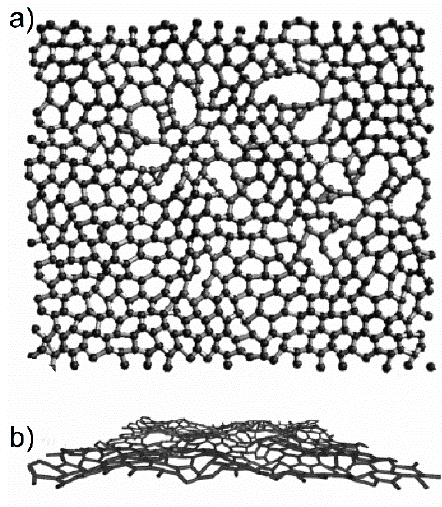
Figure 20. ( a ) Structure factor and ( b ) pair distribution function for glassy carbon heat-treated at 1000 °C, ED data—solid line, RMC modelling—dotted line. Reproduced with permission from O’Malley and Snook [91] Copyright APS Physics, 1997.